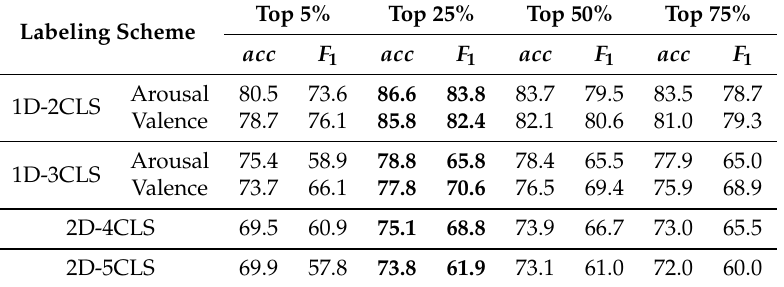
Table 7. Results of the feature-based evaluation analysis using the EEG channels of C 4 . Bold font is used to indicate the highest acc and F 1 values obtained for each EEG channel